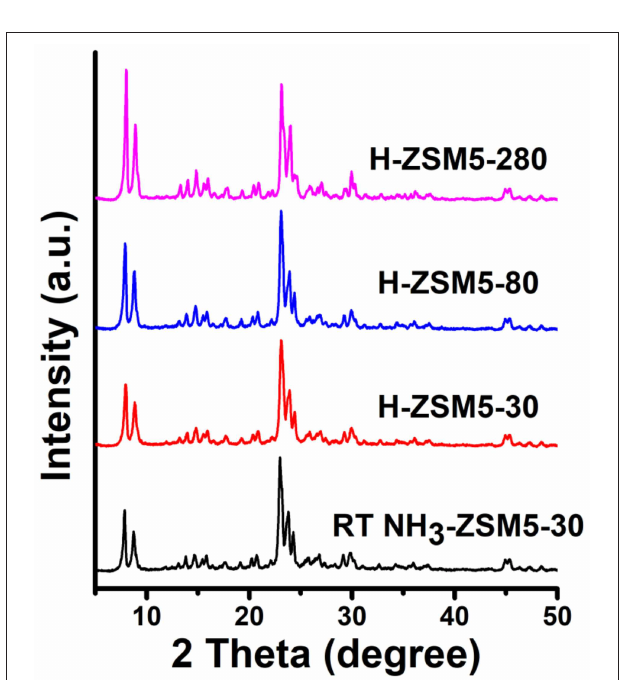
FIGURE 3 | XRD patterns of the NH 3 -ZSM-5